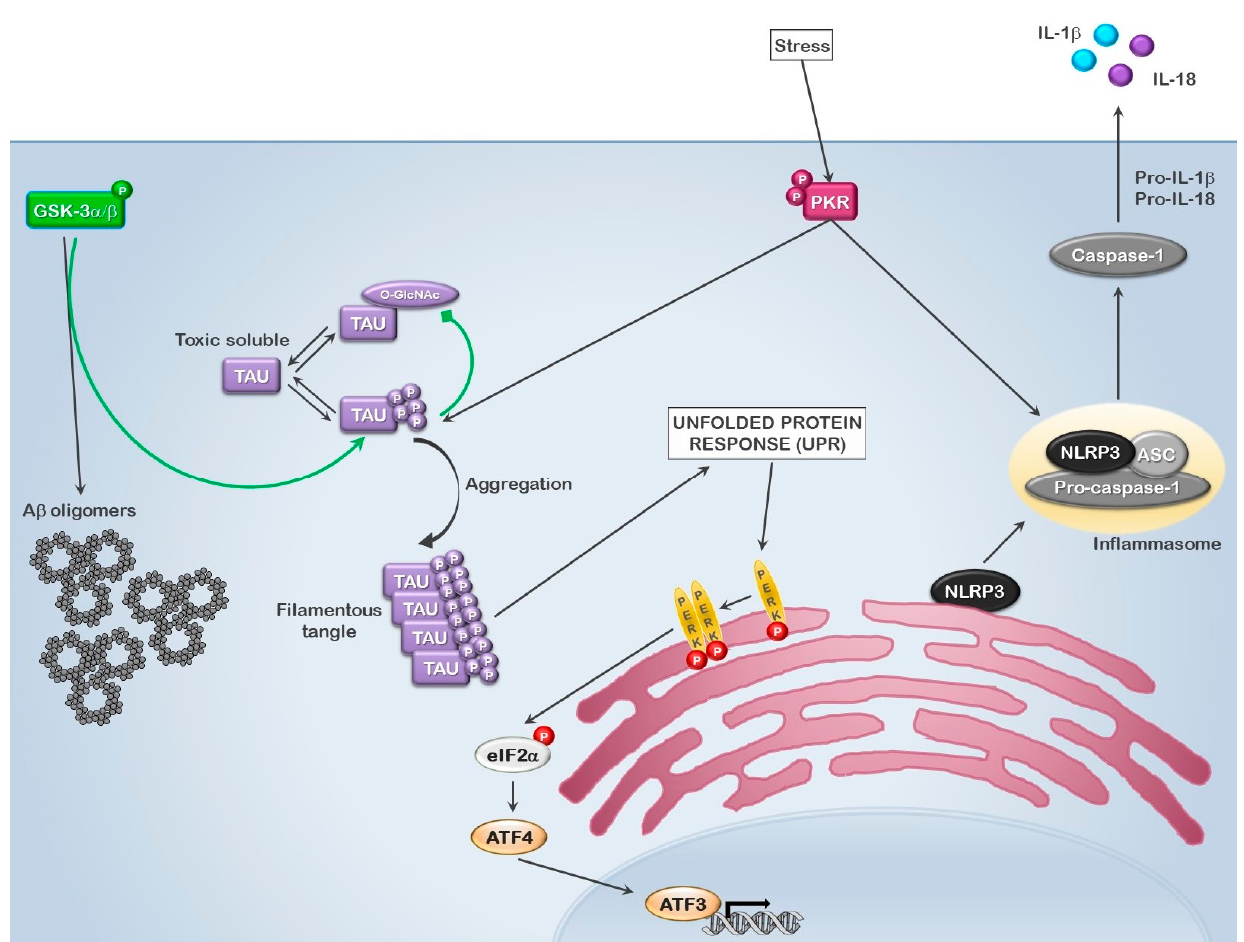
Figure 2. Role of GSK3 in the formation of inclusion bodies. GSK3 activation leads to enhanced Abeta accumulation and hyperphosphorylation of TAU, leading to the formation of inclusion bodies, resulting in cellular stress and the activation of the unfolded protein response (UPR). In conjunction with the innate immune/stress activated kinase PKR and the UPR associated kinase PERK, this leads to the phosphorylation of eIF2 α , the inhibition of general translation, IRES-mediated translation of ATF4 and the activation of the NLRP3 inflammasome, thus promoting IL-1 β release and cell death.